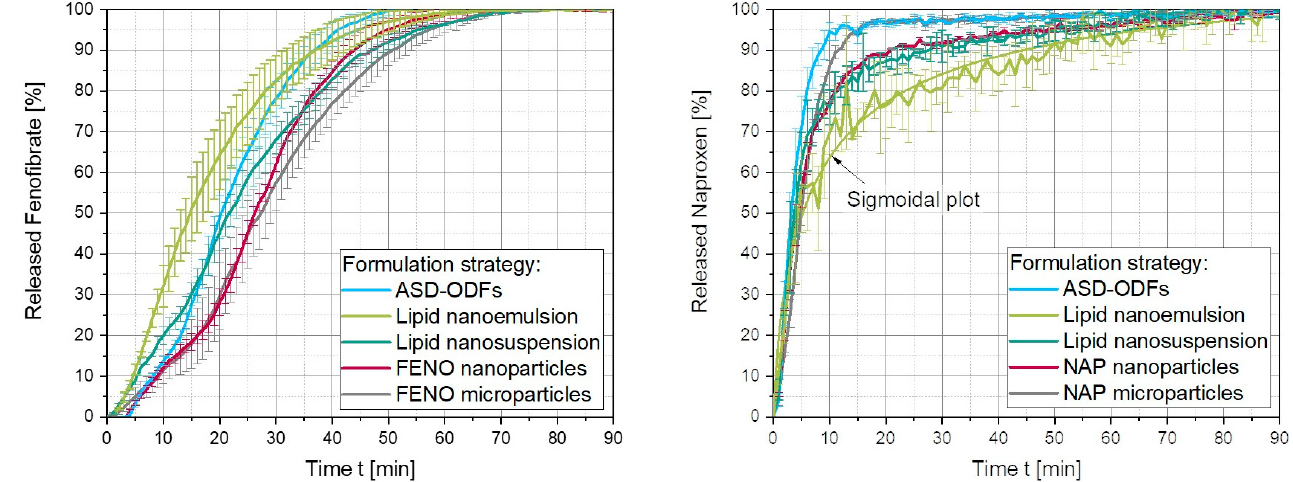
Figure 10. Dissolution behavior of FENO-loaded ( left ) and NAP-loaded ( right ) ODFs prepared by different formulation strategies, n = 6.